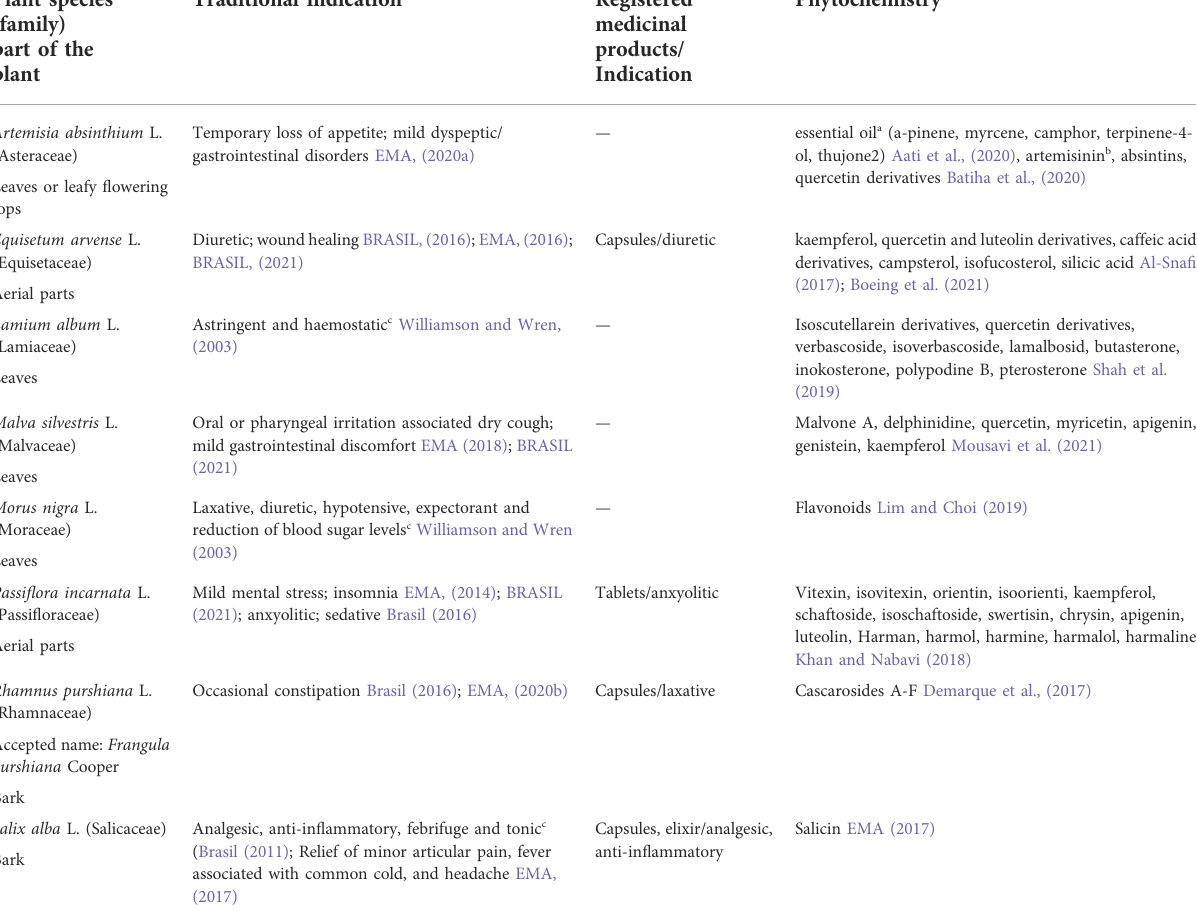
TABLE 2 Summary of the traditional indications and chemical composition of the selected European herbal